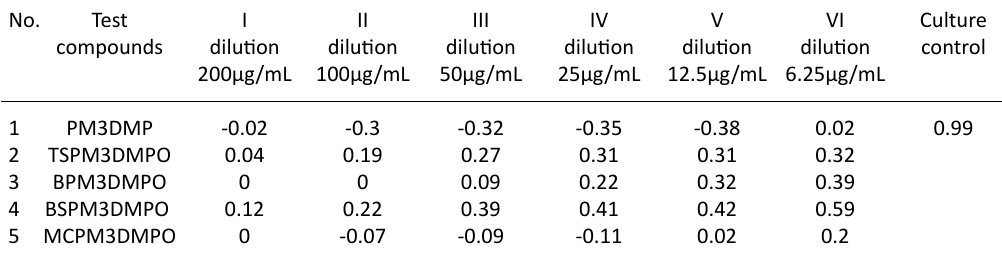
Table 8. MIC of Piperidines against Psuedomonas sp. at 600 nm No.